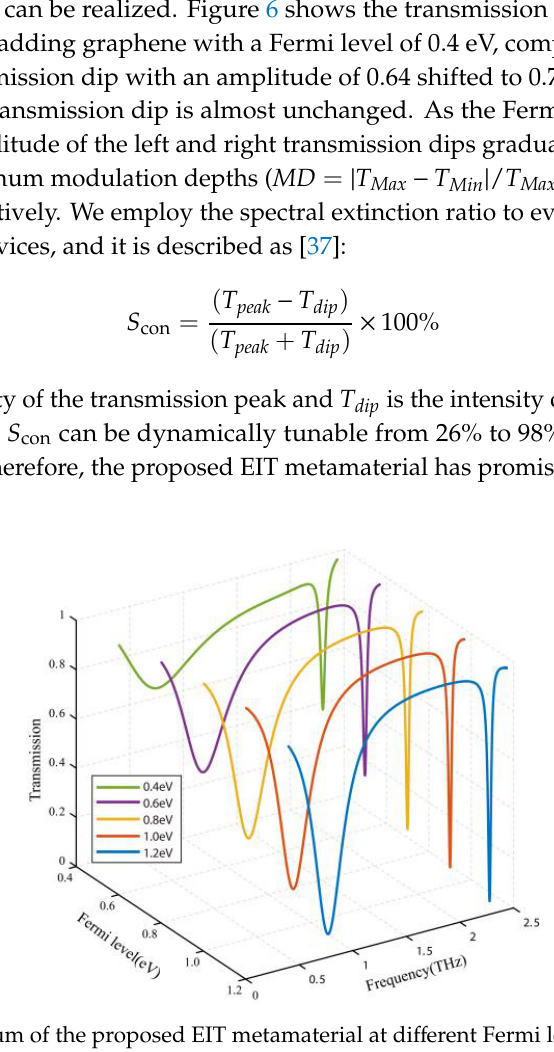
Figure 6. Spectrum of the proposed EIT metamaterial at different Fermi levels of graphene.